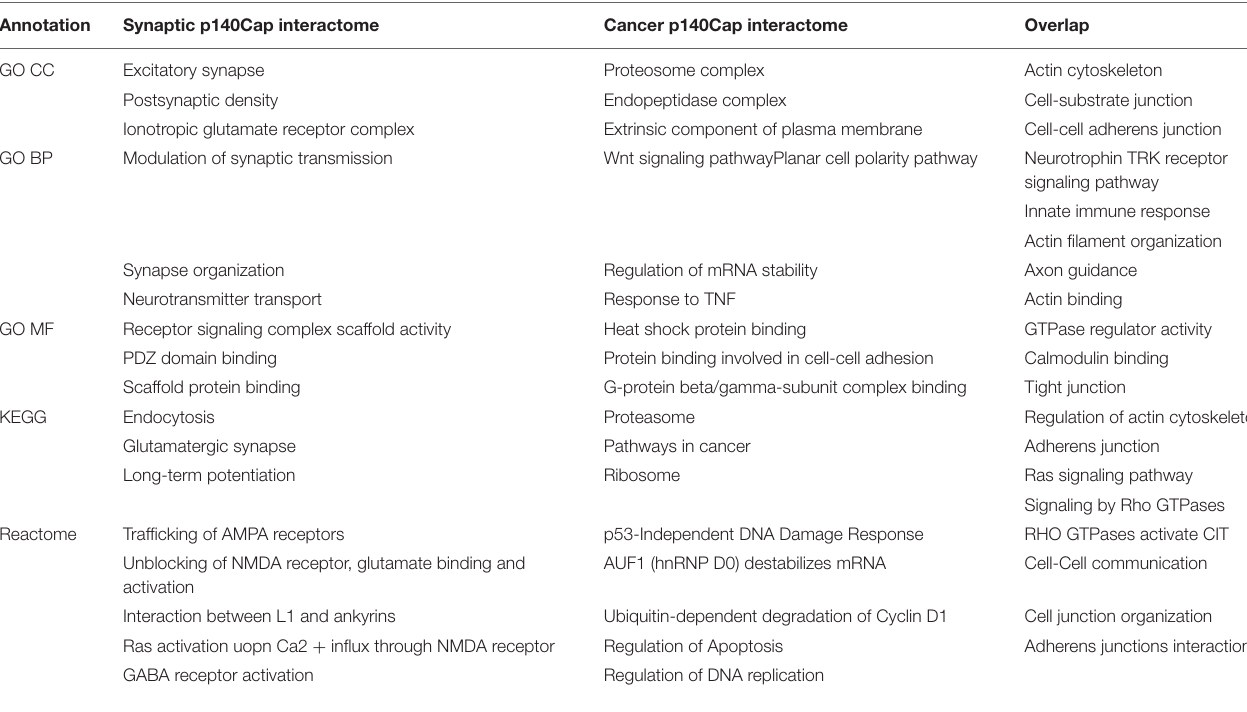
TABLE 2 | Top enrichment terms specific either for synaptic p140Cap interactome (column 1) or for cancer p140Cap interactome (column 2), and common for both (column 3).